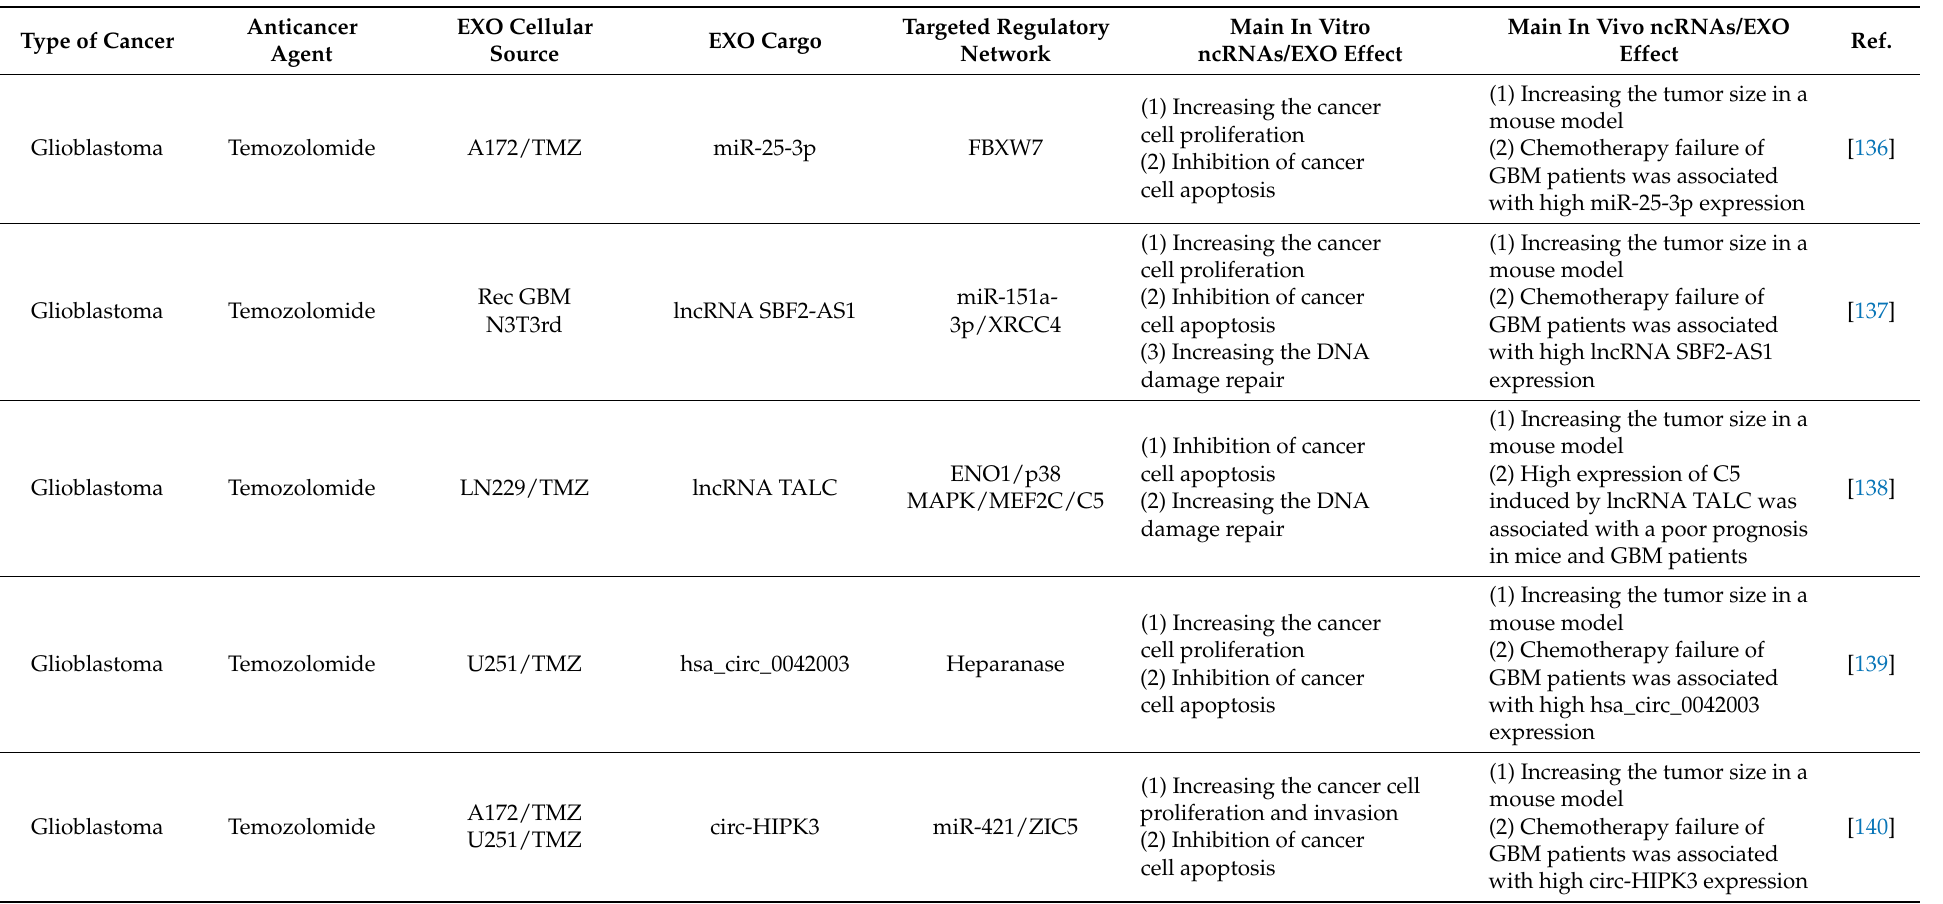
Table 2. Detailed analysis of exosomal non-coding RNAs (ncRNAs) mediated resistance to alkylating